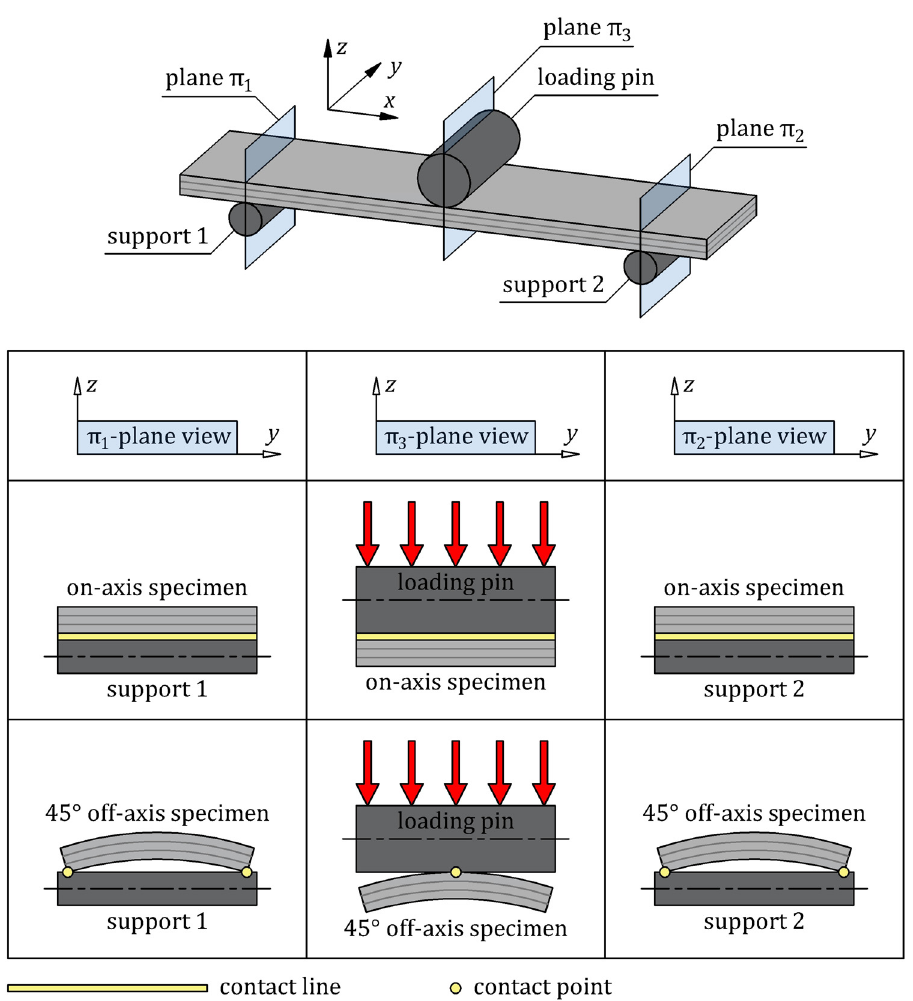
Figure 11: Comparison of transverse deformation of the on - axis and 45° o ff - axis specimens during the three - point